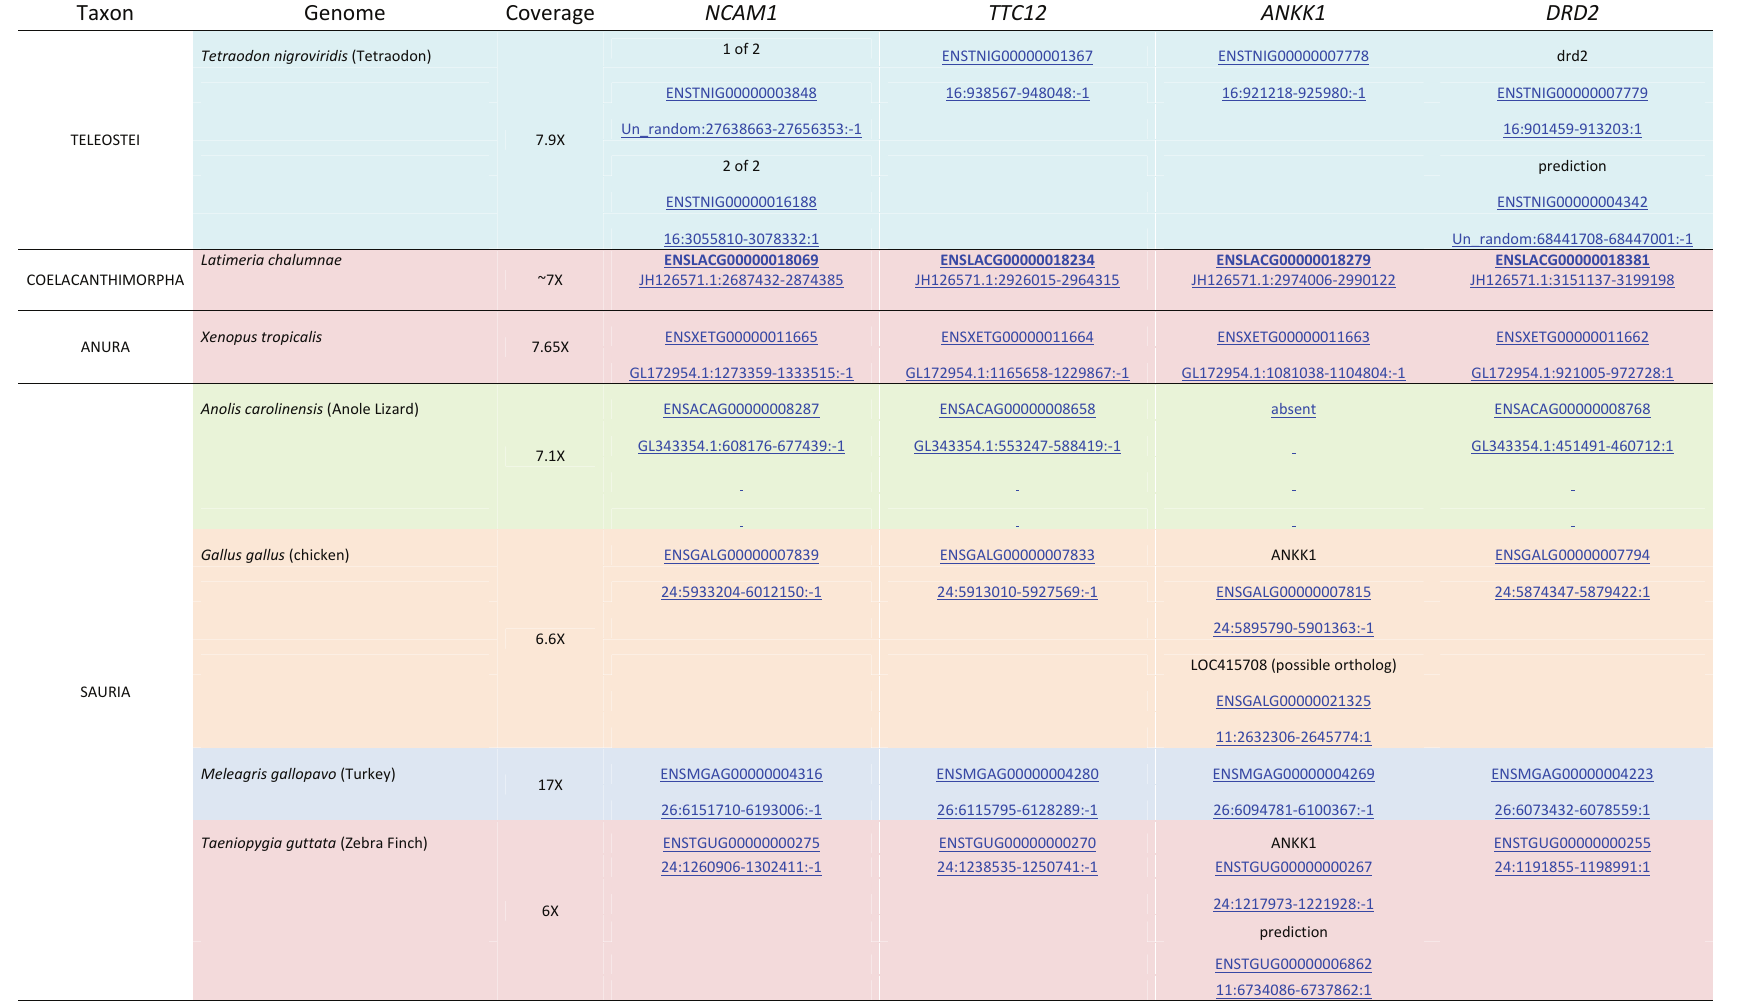
Table S1 (cont). Orthologues of genes in the NTAD cluster in 47 available vertebrate genomes, showing accession number and location.